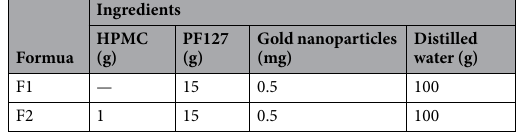
Table 1. Compositions of different thermoresponsive